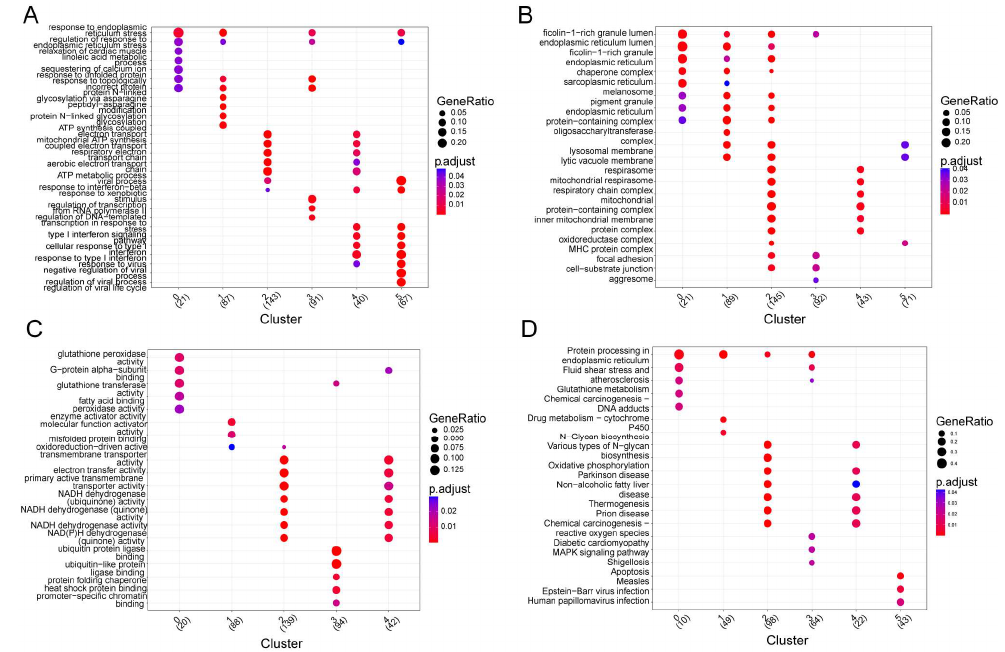
Figure 3. Functional enrichment analysis of genes within sub-clusters. ( A ). Functional enrichment analysis was conducted using the Reactome pathway database; each circular symbol represents an individual pathway. ( B – D ). Enriched GO_MF ( B ), GO_CC ( C ), and GO_BP ( D ) pathway annotation of marker genes within different sub-clusters.